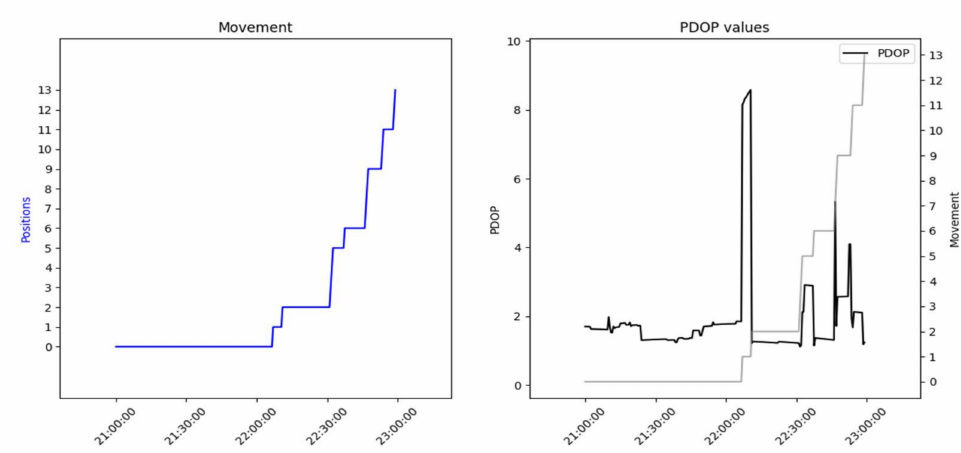
Figure 6. Diagram of moving. The left graph shows when the inspection vehicle is moving along the route. The right graph shows DOP values.